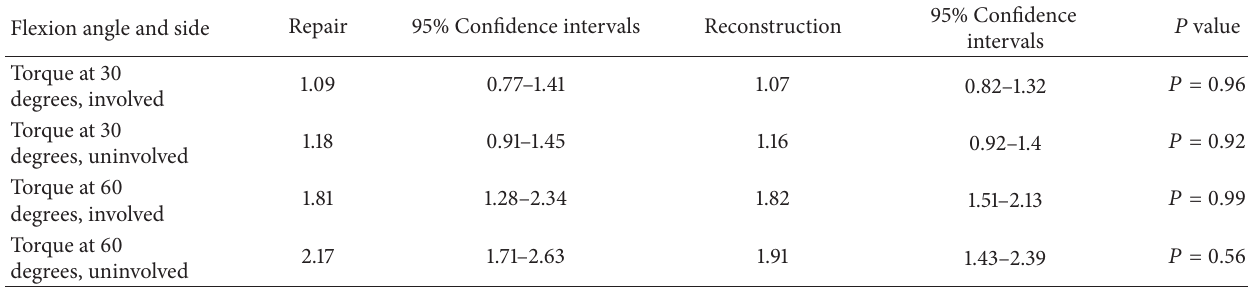
Table 1: Repair versus reconstruction comparison for torque (Nm/kg) generation of involved and uninvolved sides at 30 and 60 degrees of knee flexion.